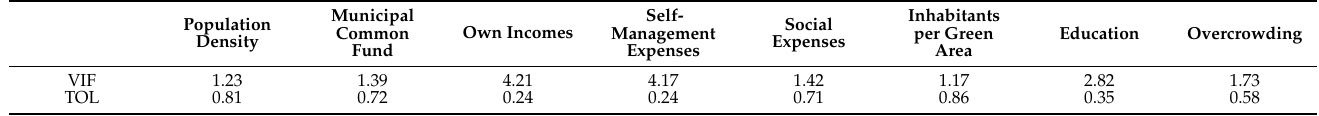
Table 8. Variance inflation factors and tolerance values for collinearity measuring.